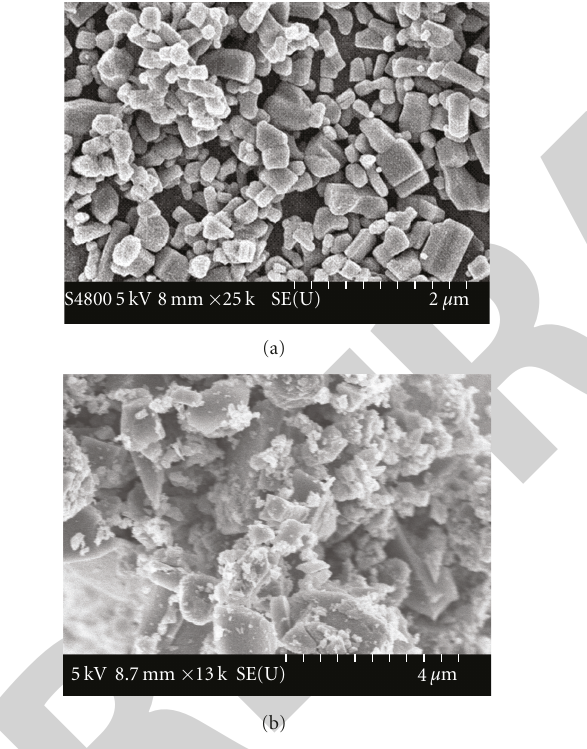
Figure 6: HR-SEM pictures of (a) TiO 2 and (b) 1.0 wt% La-doped TiO 2 .